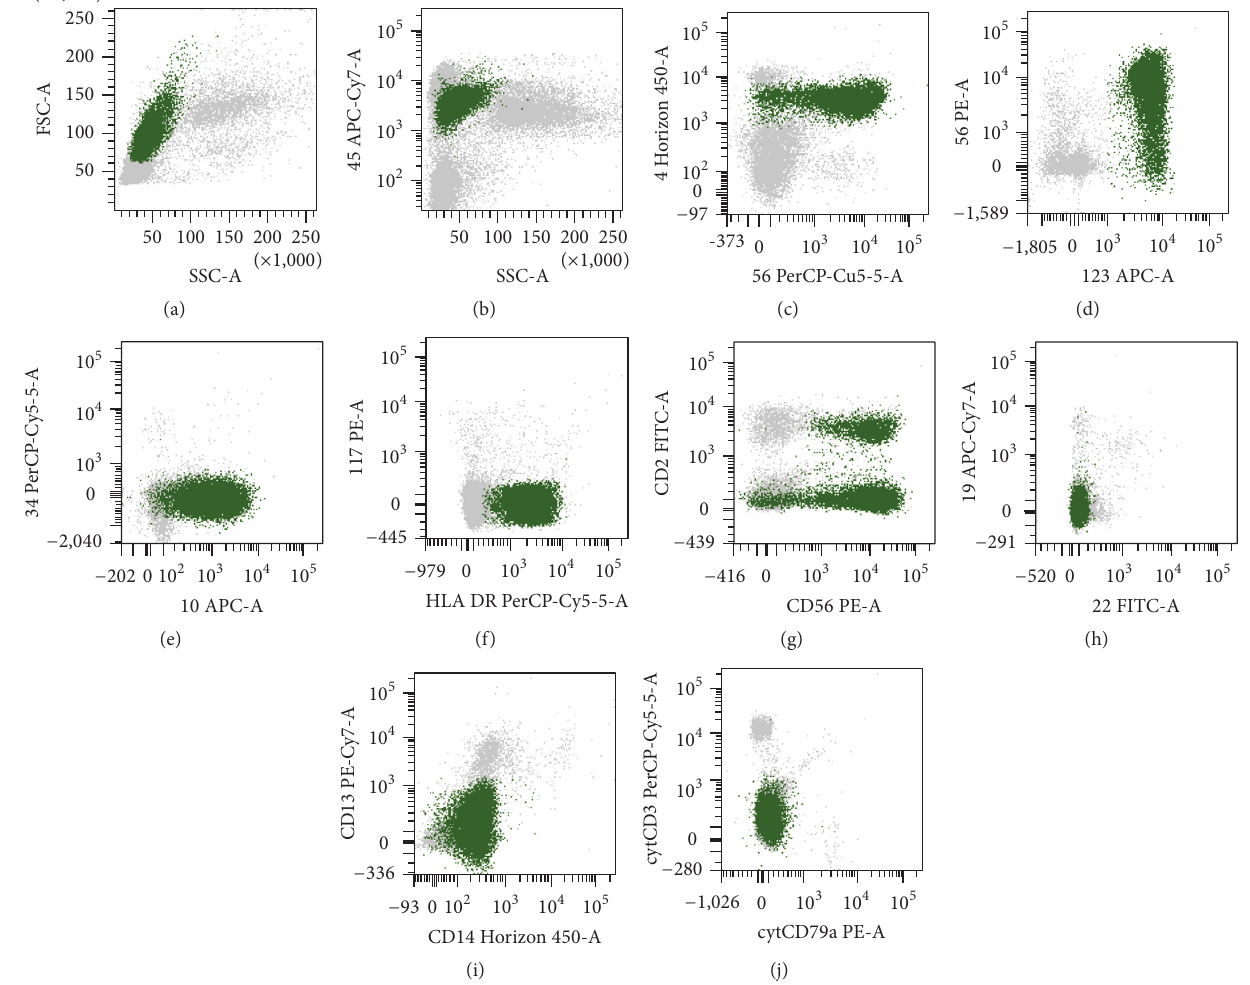
Figure 5: Immunophenotype of the bone marrow showing a large blastic plasmacytoid dendritic cell population (green): the blasts were large-sided cells with variable side scatter properties (a) and were weakly positive for CD45 (b); positive for CD4 (c), CD56 (c, d, e), CD123 (d), CD10 (e), and HLADR (f); partly positive for CD2 (g); and negative for CD34 (e), CD117 (f), CD19 (h), CD22 (h), CD13 (i), CD14 (i), cytCD3 (j), and cytCD79a